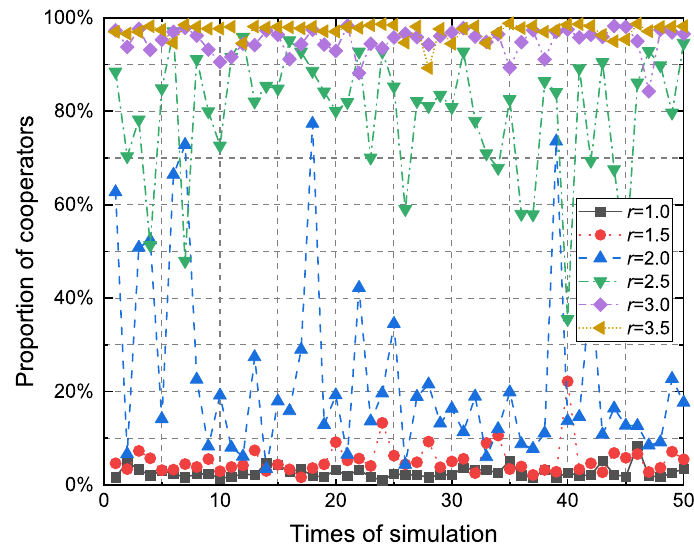
Figure 4. Proportion of cooperators for different synergy factors with respect to different simulation times (up to